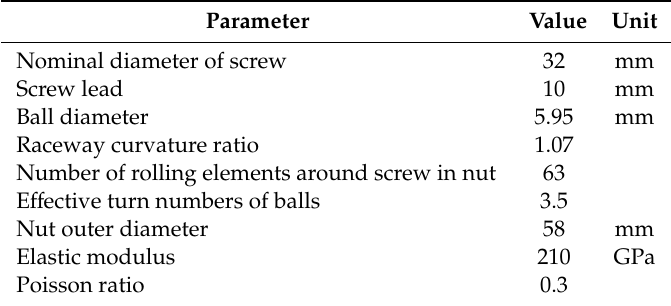
Table 1. Structure and size parameters of the